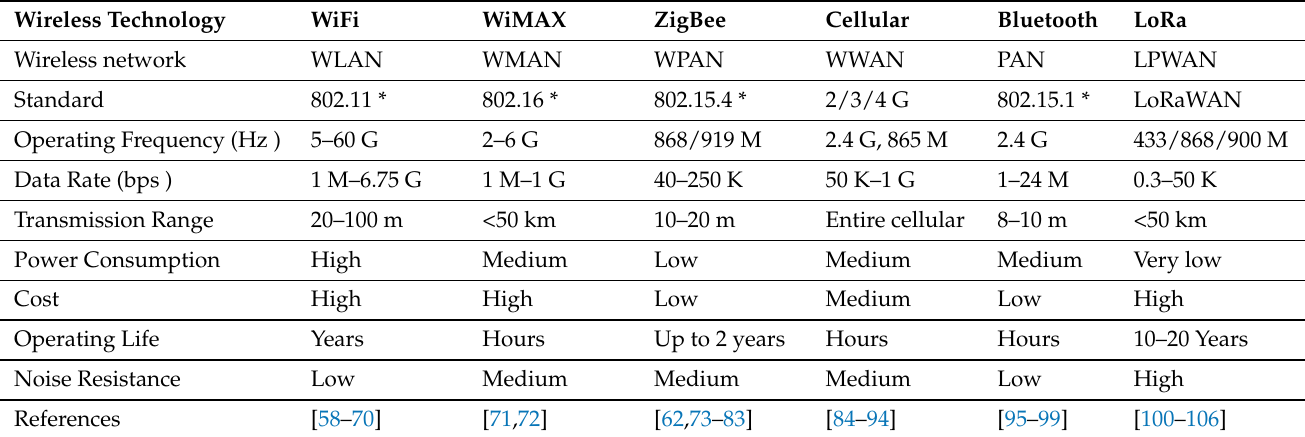
Table 2. Wireless communication technology comparison with